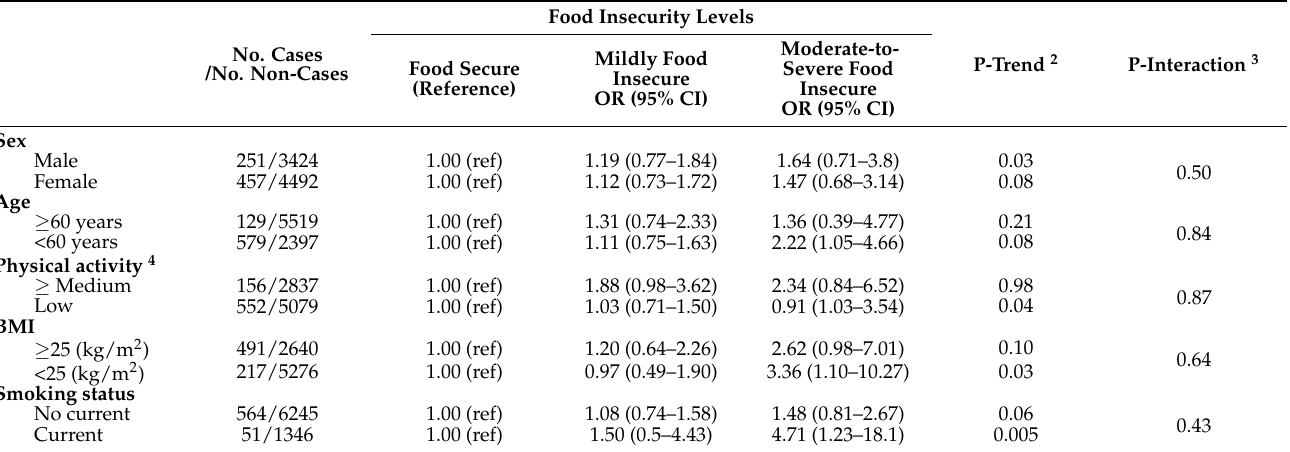
Table 4. Multivariable-adjusted 1 odds ratios (95% confidence intervals) of low muscle strength according to food insecurity levels by population